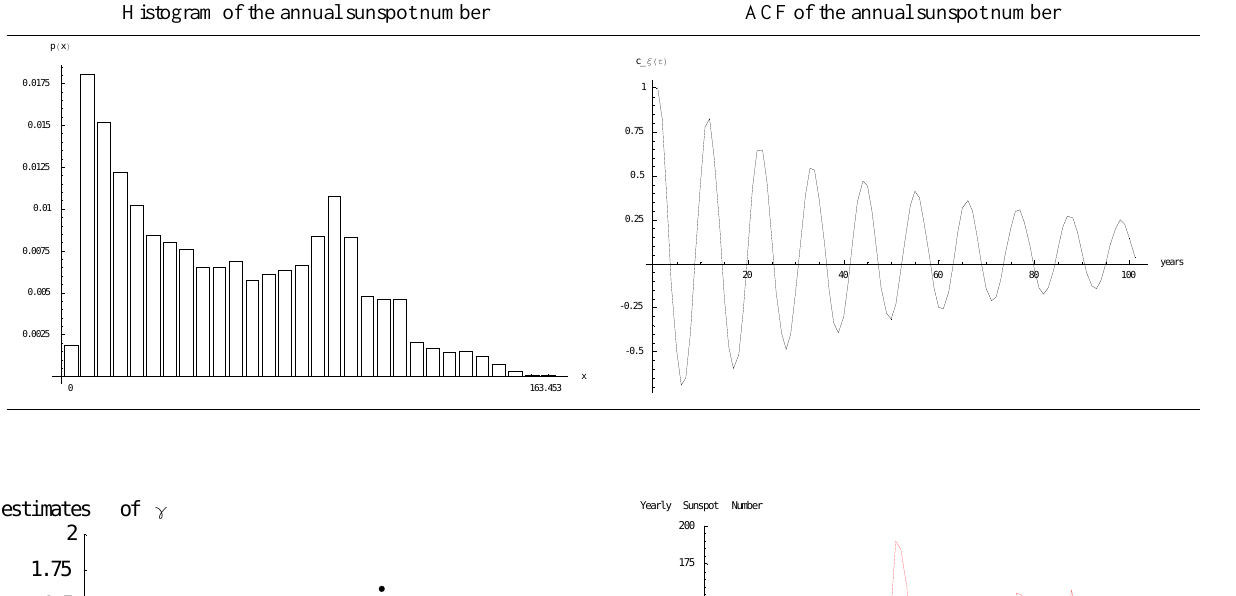
Table 3. Histogram and acf of the modelled annual sunspot number time series over 10000 years. The statistical distribution and the 11-year periodicity are quite similar to the past observed but much shorter time series. Histogram of the annual sunspot number ACF of the annual sunspot number